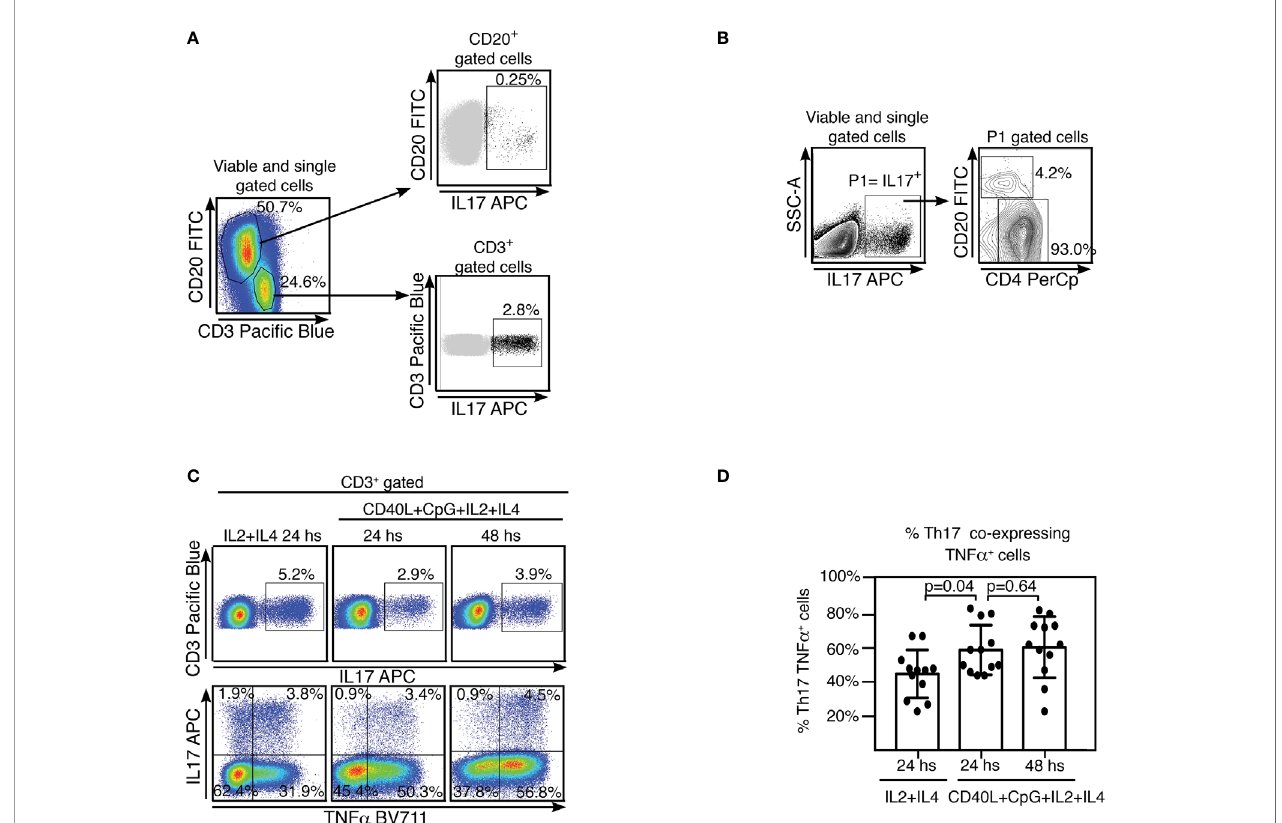
FIGURE 2 | Tonsillar Th17 cells co-express TNF a and IL17. (A) Freshly isolated TMC were cultured on CpG+CD40L+IL2+IL4 for 24 hs. Samples were subsequently analyzed by FACS. Gating strategy is partially illustrated. Singlets were gated by plotting FSC-A vs FSC-H for each sample (not shown). Within the singlets population, dead cells were determined by a fi xable viability dye (see Methods). Within the viable gate, lymphoid gate was determined through SSC-A vs FSC-A (not shown). Cells were stained for surface CD20, CD3 and intracellular IL17. Pseudo-color plots show CD3 and CD20 expression by TMC upon stimulation, percentages designate frequencies of populations in each gate (left panel). Upper right panel: dot plot shows IL17 and CD20 expression by TMC, CD20 + IL17 + population is highlighted in black and its frequency within CD20 + population is indicated as percentage. Lower right panel: dot plot shows IL17 and CD3 expression by TMC, CD3 + IL17 + population is highlighted in black and its frequency within CD3 + population is indicated as percentage. Data from one experiment representative of 10 independent experiments performed with different individuals each one, are presented. (B) Gating strategy used to estimate the populations contributing to the IL17 + cell subset upon stimulating strategy as in (A) . Singlets were gated by plotting FSC-A vs FSC-H for each sample (not shown). Within the singlets population, dead cells were determined by a fi xable viability dye (see Methods). Within the viable gate, lymphoid gate was determined through SSC-A vs FSC-A (not shown). P1 denotes IL17 + cell population determined by IL17 vs SSC-A contour pro fi le. Panel on the right, representative contour plots for CD20 + and CD4 + populations within the P1 gate. Percentages designate frequencies of the populations indicated relative to P1 gate. Data from one experiment representative of 6 independent experiments performed with different individuals each one, are presented (C) Freshly isolated TMC were cultured on IL2+IL4 alone or CpG+CD40L+IL 2+IL4, for the time points indicated on the top of each panel. Singlets were gated by plotting FSC-A vs FSC-H for each sample (not shown). Within the singlets population, dead cells were determined by a fi xable viability dye (see Methods). Within the viable gate, lymphoid gate was determined through SSC-A vs FSC-A (not shown). Cells were stained for surface CD20, CD3, intracellular TNF a and IL17 and fi nally analyzed by FACS. Upper panels: pseudo-color plots show IL17 vs CD3 expression by TMC. They correspond to events within singlets, viable, lymphoid and CD3 + gates. Percentages designate frequencies of IL17 + cells within CD3 + . Lower panels: pseudo-color plots show TNF a and IL17 expression by TMC, gated as in the upper panels. Percentages designate frequencies of populations in each quadrant, relative to the CD3 + gate. Data from one experiment representative of 12 independent experiments performed with different individuals each one, are presented. (D) Histograms presenting the mean percentage ± SD of the Th17 TNF a + cell population frequencies from 12 independent experiments for each stimulating condition, calculated as shown in (C) , top right quadrant. p calculated through a Mann-Whitney test as the distribution of data in the middle column was not normally